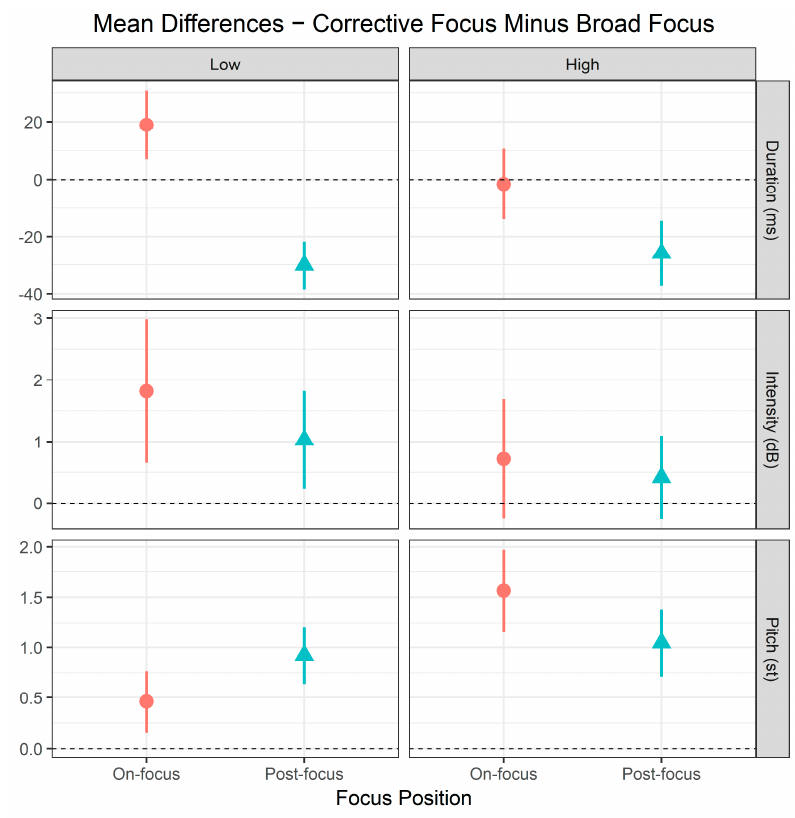
Figure 6. Mean differences in duration (ms), intensity (dB), and pitch (st) of the two focus positions between corrective focus and broad focus. The horizontal dotted line at 0 on the y-axis indicates that the difference between corrective and broad focus conditions equals zero, and values above 0 indicate that the value of the corrective-focus condition exceeds that of the broad-focus counterpart.